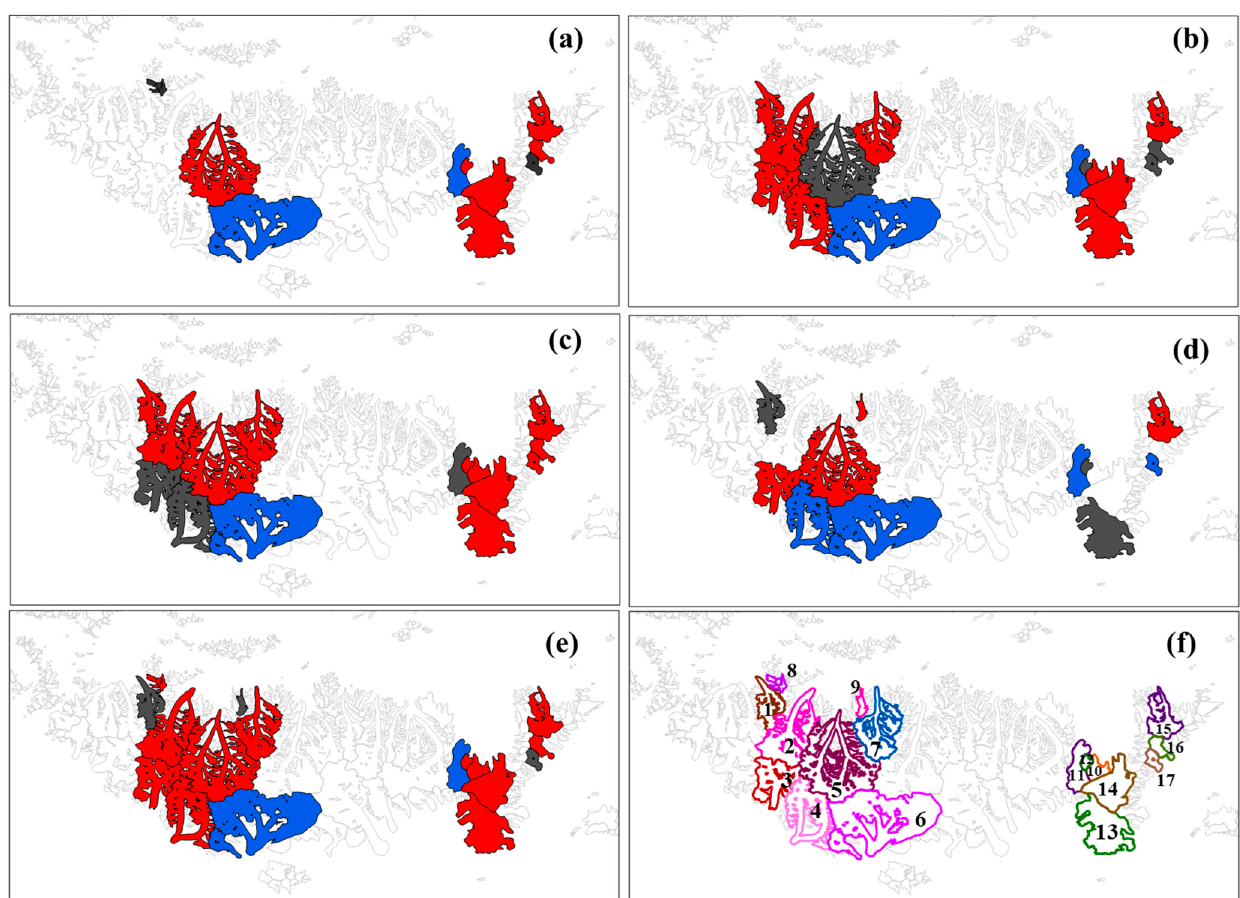
Figure 3. Trends of dh values between ICESat and SRTM during 2003–2008 for 17 local glaciers in the WKM region. Mean trends for individual glaciers are shown in different colors (red: thickening, blue: thinning, grey: in balance within ±0.1 m/a). ( a ) Winter, ( b ) autumn, ( c ) accumulation area, ( d ) ablation area, ( e ) on-glacier area, and ( f ) distribution of individual glaciers with ICESat measurements within the WKM region.